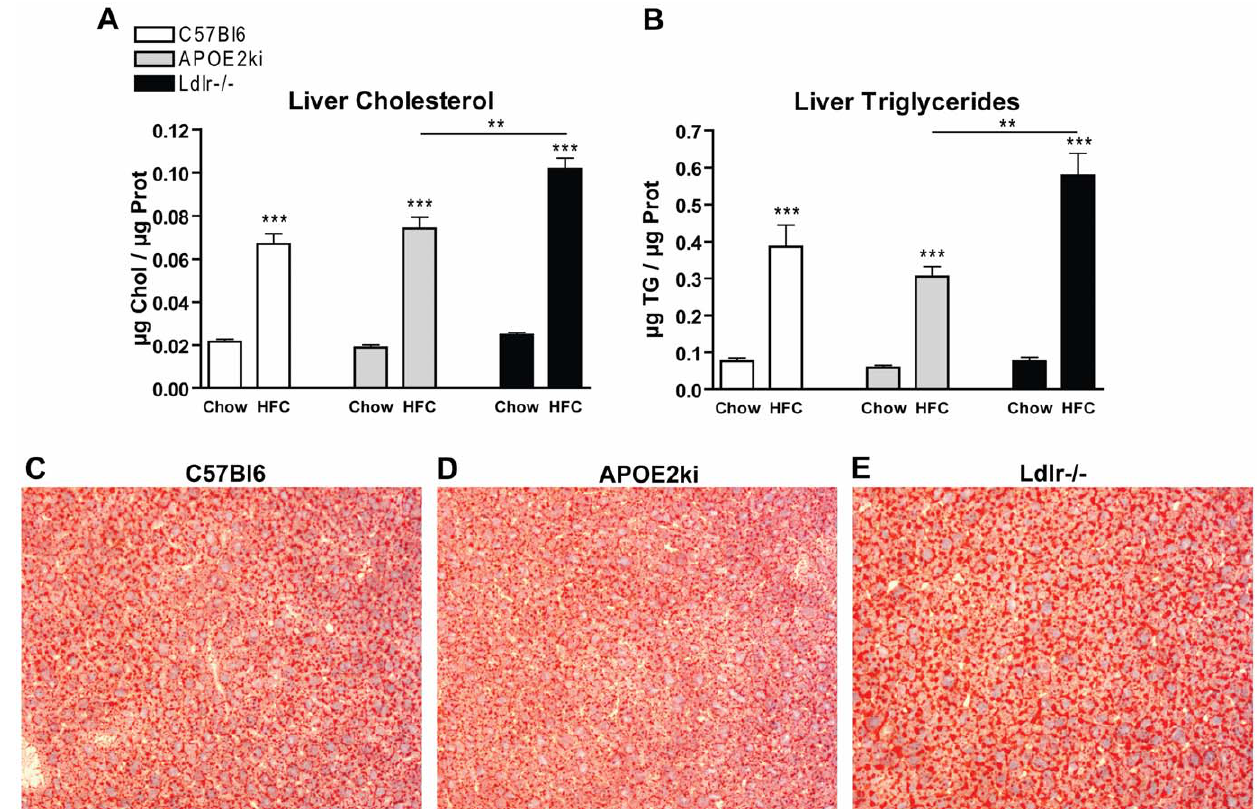
Figure 2. Parameters of hepatic steatotis. (A + B) Liver cholesterol and triglycerides after chow and 3 months of HFC diet in C57Bl6, APOE2ki and Ldlr 2 / 2 mice. (C–E) Representative pictures ( 6 200 magnification) of the Oil red O staining after the chow diet and 3 months of the HFC diet in C57Bl6, APOE2ki and Ldlr 2 / 2 mice.